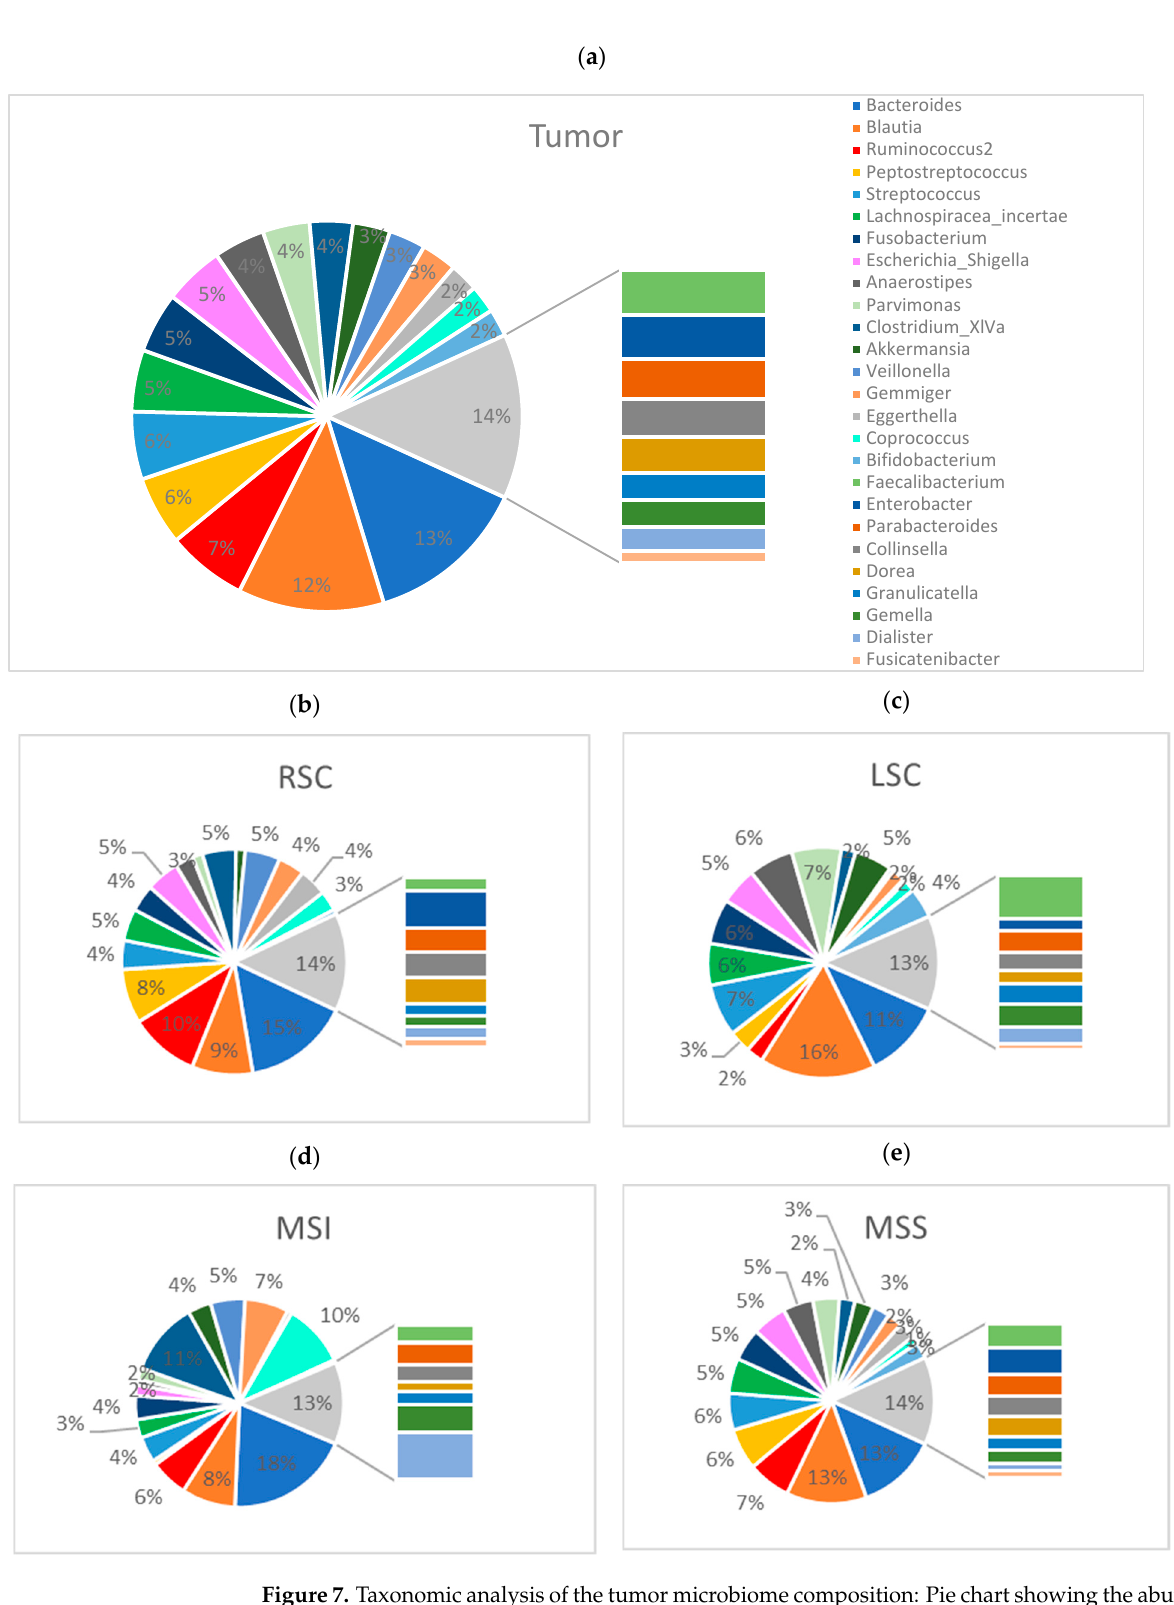
Figure 7. Taxonomic analysis of the tumor microbiome composition: Pie chart showing the abundance profile of the tumor samples ( a ), RSCC subgroup ( b ), LSCC subgroup ( c ), MSI subgroup ( d ) and MSS subgroup ( e ) at the genus